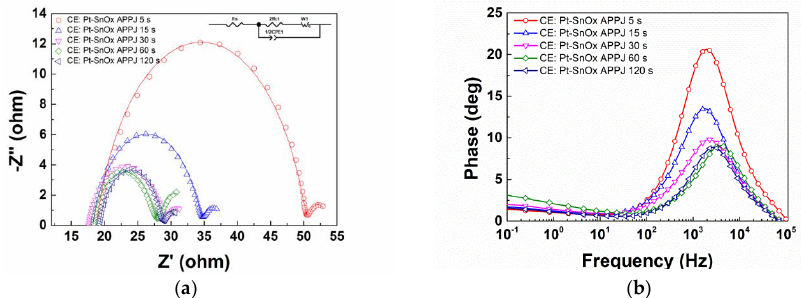
Figure 5. ( a ) Nyquist curves of symmetric cells with two Pt-SnO x CEs. The inset shows the equivalent circuit diagram. ( b ) Bode phase plots of symmetric cells with two Pt-SnO x CEs. Table 3. EIS parameters of Pt-SnO x CEs.